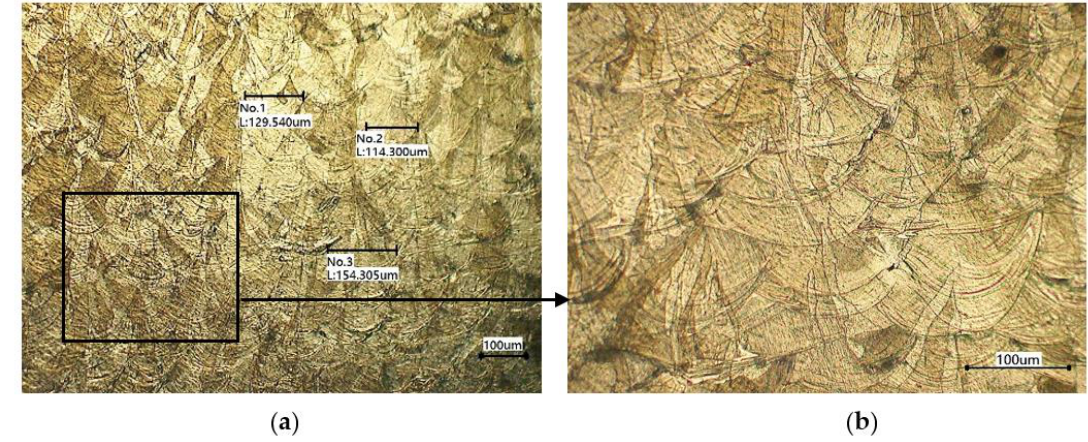
Figure 11. Morphology of the cross-section molten pool after SLM formation: ( a ) Cross-section; ( b ) Partial enlarged detail.